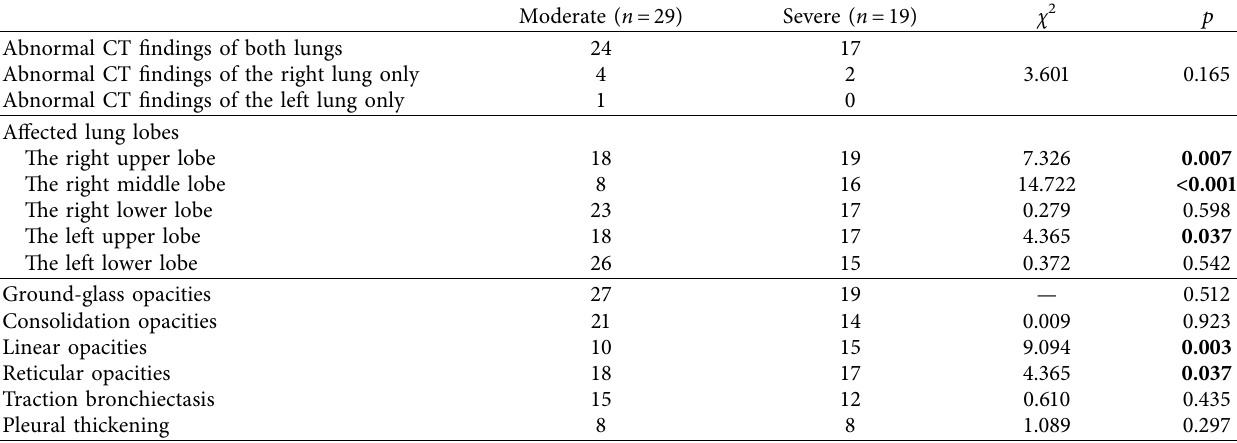
Table 4: Comparison of chest CT between moderate and severe patients at the peak of hospitalization.